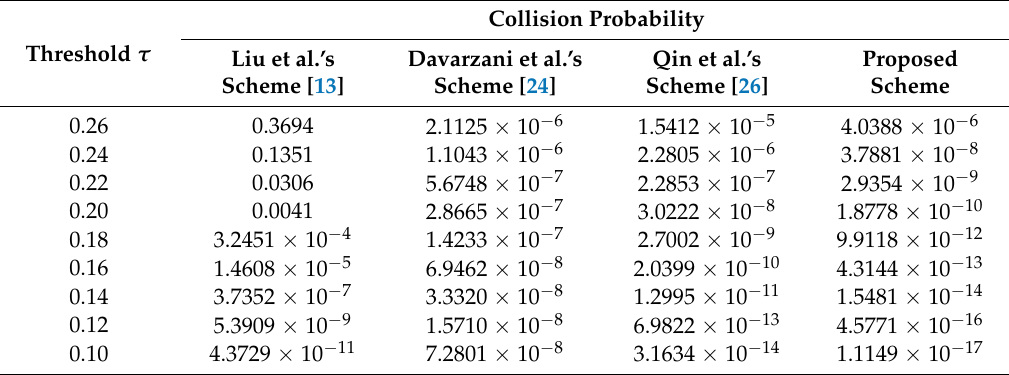
Table 3. A comparison of collision probability of different schemes under various thresholds.